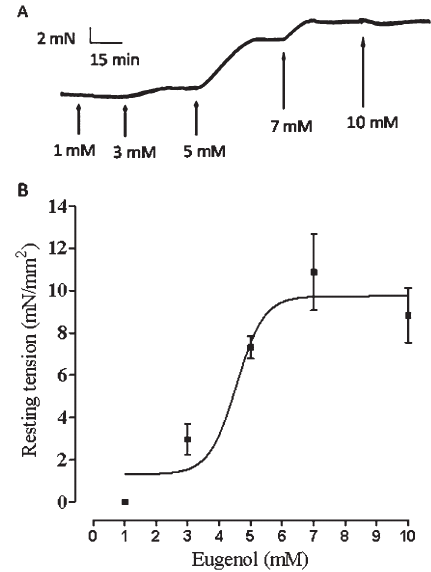
Figure 1. Effect of eugenol on the resting tension of rat atria muscle. A , Typical record of the effect of eugenol at different concentrations (1, 3, 5, 7, and 10 mM). B , Dose-response relationship of eugenol on the resting tension (n=6).